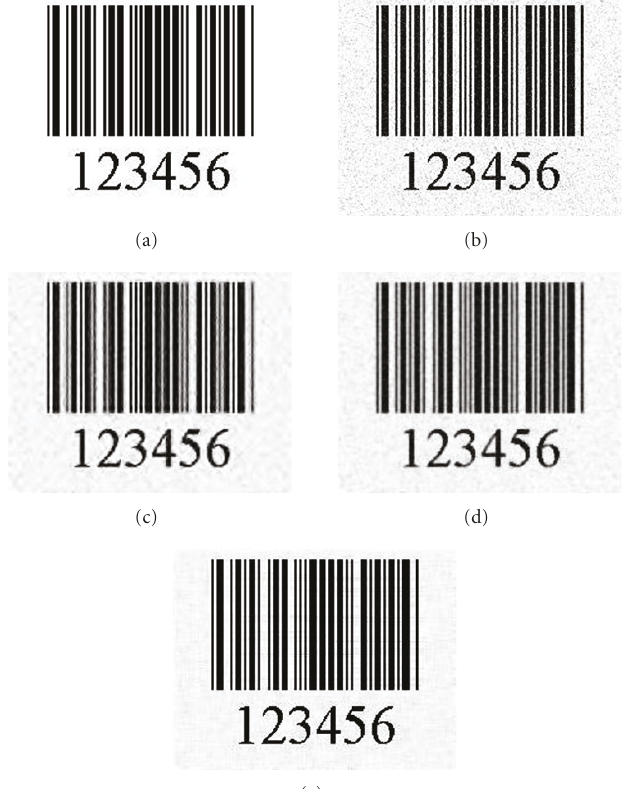
Figure 11: (a) BarCode image, (b) noisy image with Gaussian noise with σ = 0 . 05, (c) denoised image by wavelet, PSNR = 17 . 762, (d) denoised image by ADF, PSNR = 16 . 940, and (e) denoised image by the proposed procedure, PSNR = 28 . 021.